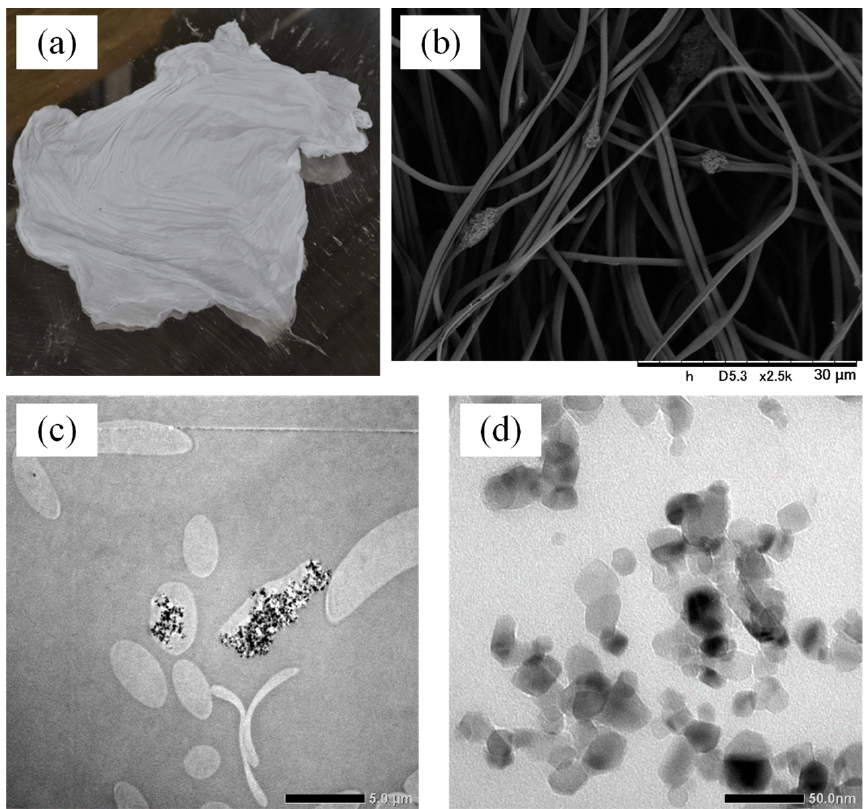
Figure 1. Photographs of TiO 2 nanoparticle-loaded fiber: ( a ) digital image, ( b ) SEM image (scale bar: 30 μm), ( c ) TEM image (scale bar: 5 μm), and ( d ) TEM image (scale bar: 50 nm).